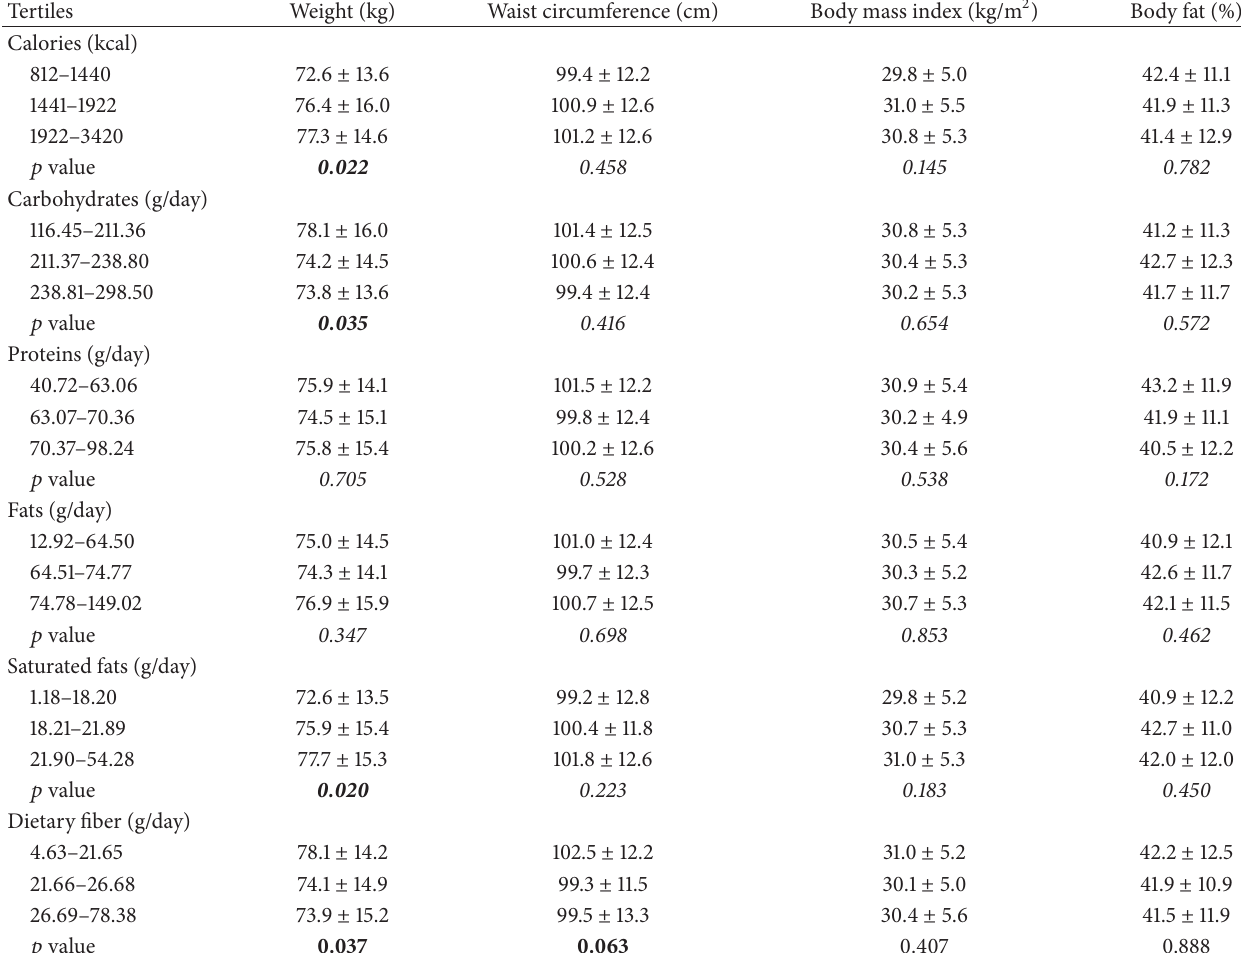
Table 4: Association of diet components with anthropometric and body composition